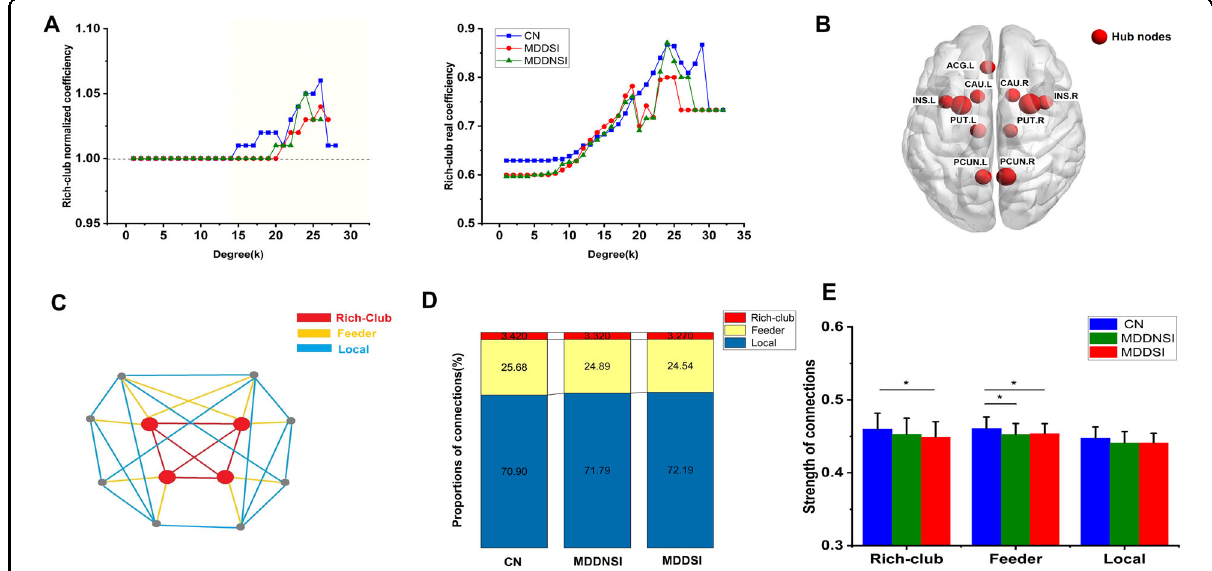
Fig. 1 Rich-club organization of structural network. A Normalized and real rich club organization curves for the structural group-averaged brain network in CN (blue line), MDDSI (red line), and MDDNSI (olive line) (K > 14, P = 0.026, 5000 permutations). B Distributions of hub nodes (red nodes) in all individuals. C Description model for rich club organization. Structural connections cross individual brain network was divided into 3 distinct subtypes: rich-club (red lines) connections link rich-club members, feeder connections (yellow lines) link rich-club members to non-rich-club members, and local connections (blue lines) connect non-rich-club members. D The proportions of rich-club, feeder, and local connections in the structural group-averaged brain networks of each group. E The integrated connection strength of each sub-properties (rich-club, feeder, local) of rich club organization. Color icon as before. The error bars indicate standard deviation. * P < 0.05. CN, cognitively normal; MDDSI, major depression disorder with suicidal ideation; MDDNSI, major depression disorder with non-suicidal ideation; INS.L, left insula; INS.R, right insula; CAU.L, left caudate; CAU.R, right caudate; PUT.L, left putamen; PUT.R, left putamen; THA.L, left thalamus; THA.R, right thalamus; PCUN.L, left precuneus; PCUN.R,